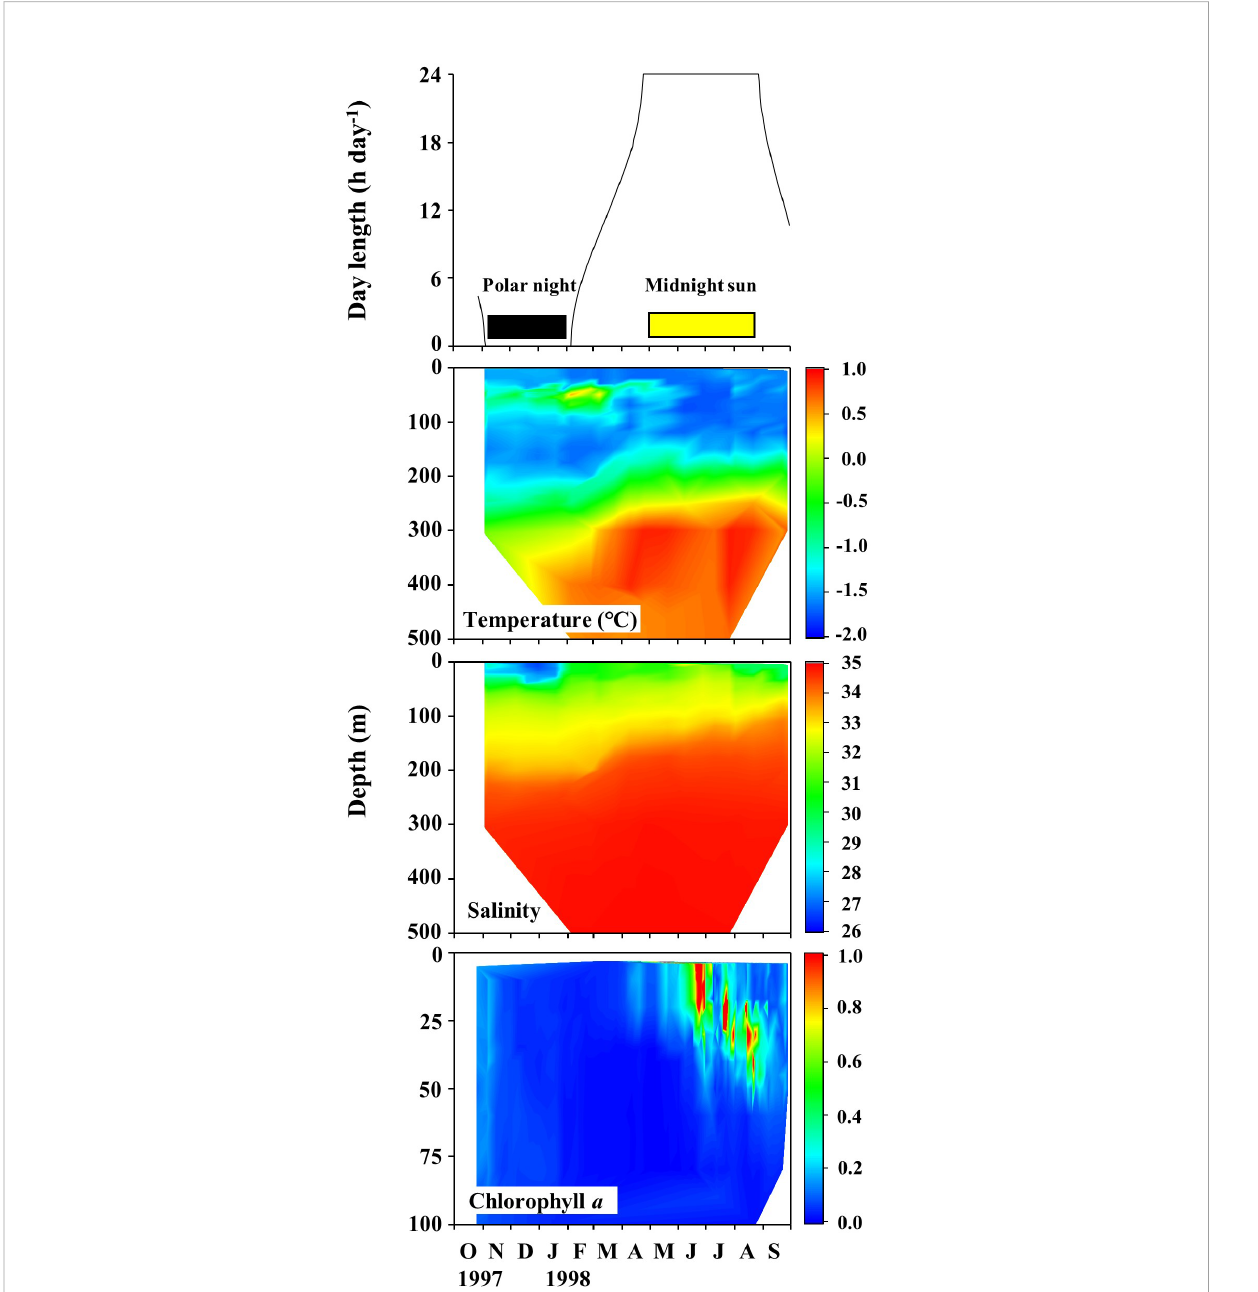
FIGURE 3 Seasonal changes in daylength, temperature, salinity, and chlorophyll a fl uorescence recorded at the Surface Heat Budget of the Arctic Ocean (SHEBA) ice station as it drifted through the Canada Basin to the Mendeleev Plain from 27 October 1997 to 29 September